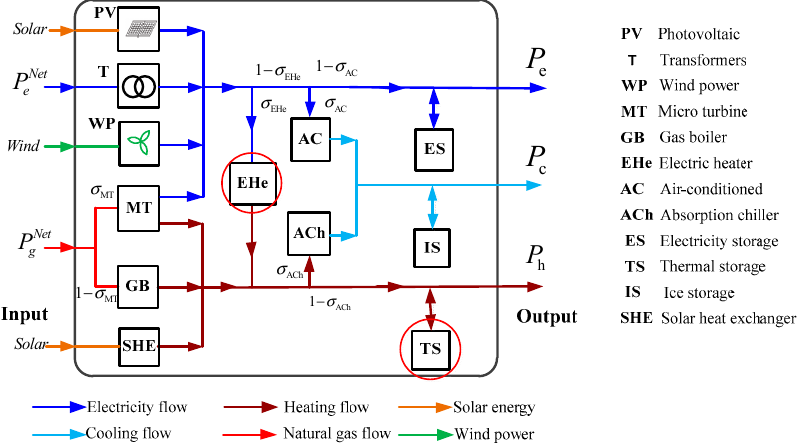
Figure 10. The optimal structure of the EH model. Table 3. The optimal operating structure corresponding to the value of binary variables.